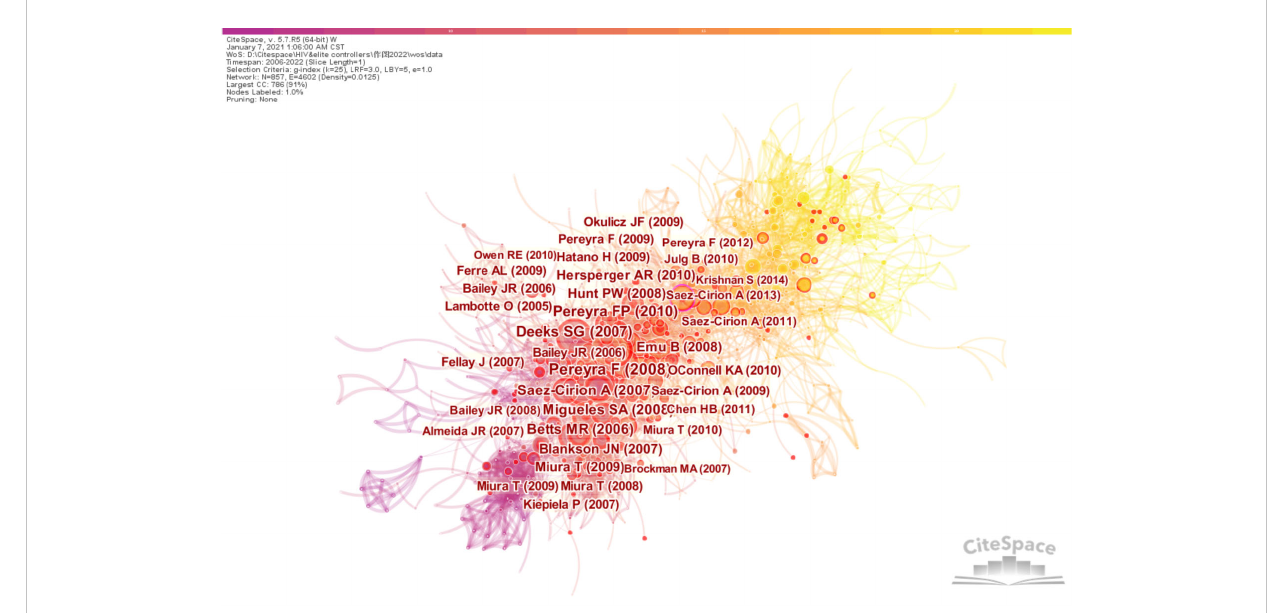
FIGURE 5 Visual analysis of 857 cocited references in the fi eld of elite controller research via